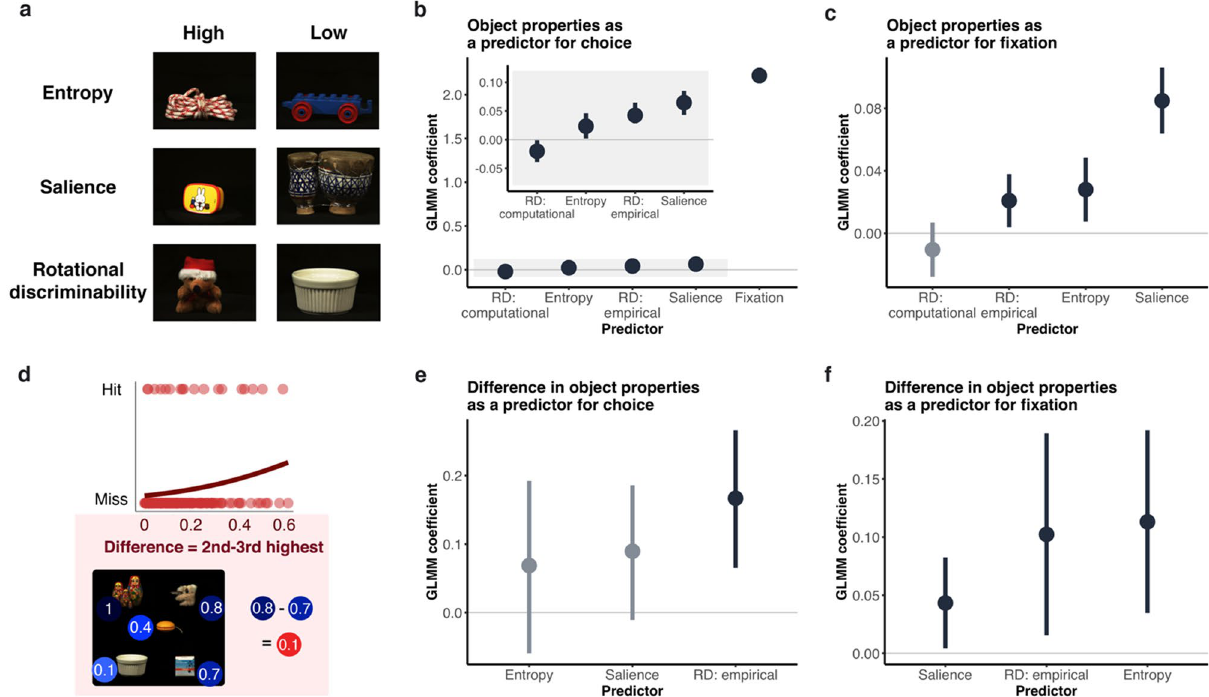
Figure 5. Object features as predictors of report choice and fixation. ( a ) Example images with high and low feature levels. ( b ) Model coefficient estimates from GLMM with object features as a predictor of report choice. The shaded area in the inset panel is a zoomed axis of the main plot. ( c ) Model coefficient estimates from GLMM with object features as a predictor of fixation. ( d ) Example of how the feature difference plots in E and F are calculated. The plot from an example observer shows the difference between the 2nd and 3rd highest rotational-discriminability of objects as a predictor for report choice, with the diagram depicting the difference calculation from a trial with arbitrary example values. Hits refer to trials where participants chose or fixated the two highest feature-value objects; miss refers to all other trials. ( e ) Model coefficient estimates from separate GLMMs for each feature, relating relative differences in object properties to report choices. ( f ) Model coefficient estimates from separate GLMMs for each feature, relating relative differences in object properties to fixation. ( b, c, e, f ) Error bars are 95% confidence intervals. Significant predictors are depicted in dark grey, insignificant in light